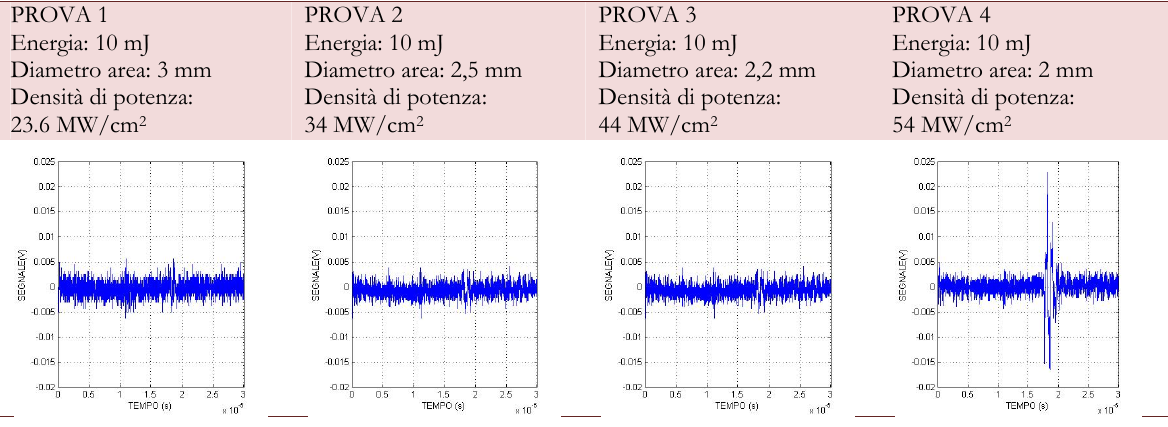
Tabella 1: Prove sperimentali per ricavare il coefficiente di riflessione della superficie